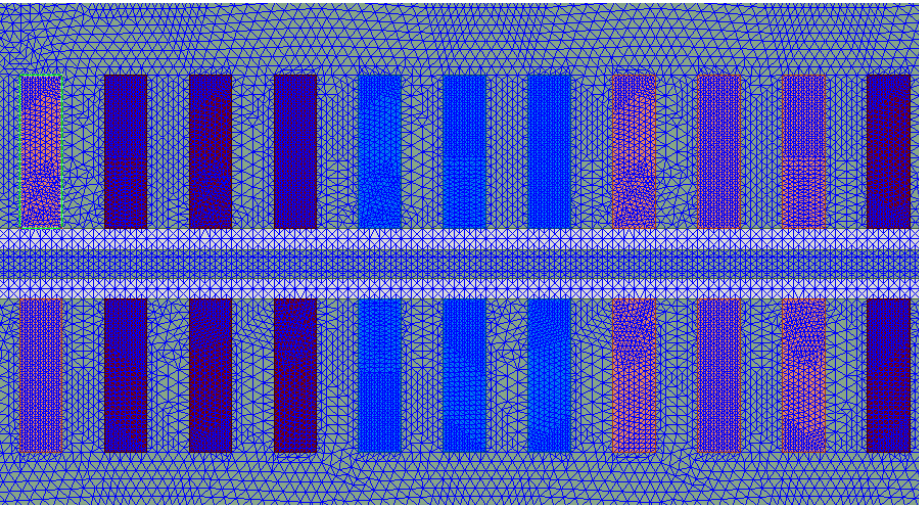
Figure 6. Part of the mesh plot of the optimal SP-DLIM.